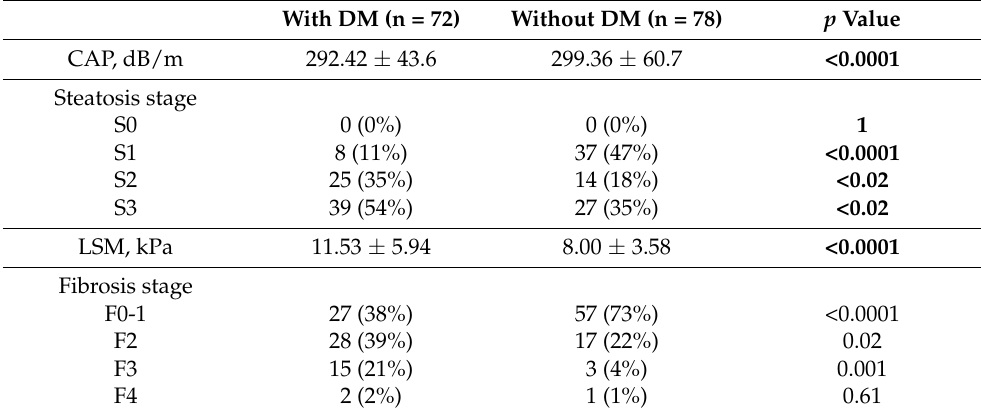
Table 2. Assessment of hepatic fibrosis and